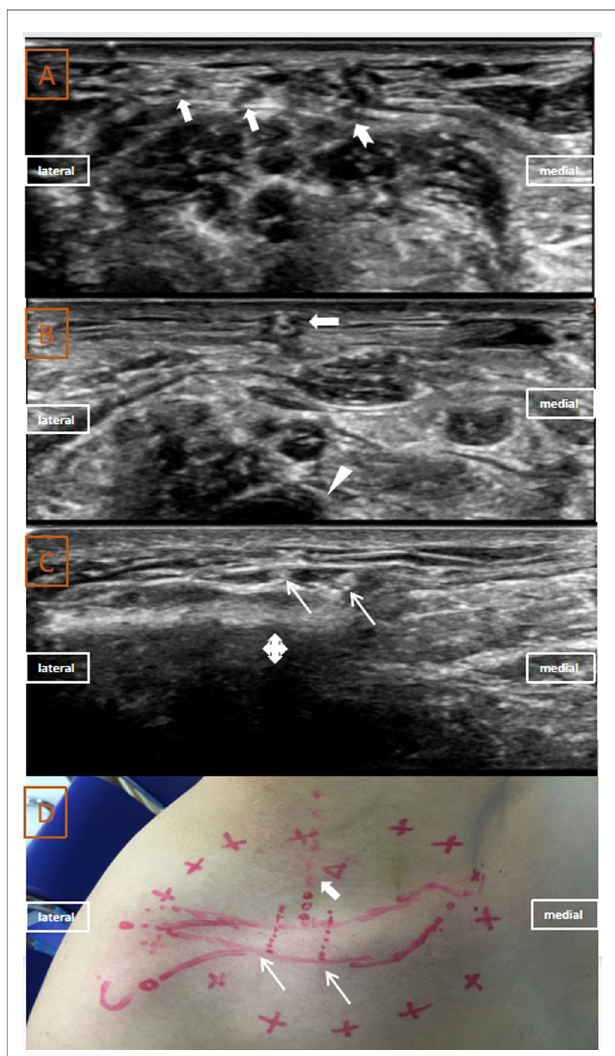
FIGURE 1 | Ultrasound images, projection on the body surface and sensory block area of the supraclavicular nerve in Case 1: ( A ) ultrasound images of phrenic nerve (indicated with swallowtail arrow) and super fi cial cervical plexus (indicated with a thick white arrow); ( B ) ultrasound image of the supraclavicular nerve (indicated with a thick white arrow) anterior to the supraclavicular artery (indicated with a white arrowhead); ( C ) ultrasound images of branches of the supraclavicular nerve (indicated with thin white arrows) anterior to the clavicle (indicated with a cross arrow); ( D ) projection of the supraclavicular nerve on the body surface (indicated with a white arrow) and the sensory block area (red